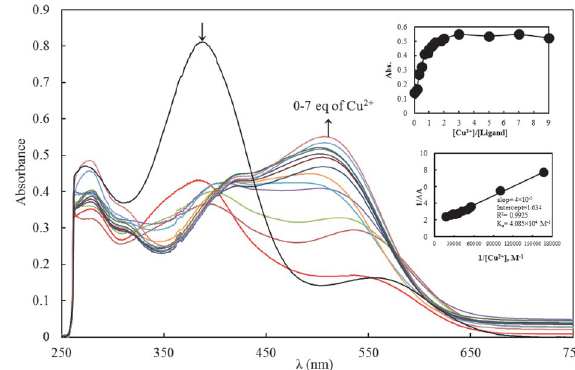
Fig. 5 . Changes in the UV–vis spectra of 1 (0.020 mM) upon titra- tion by Cu(CH 3 COO) 2 in a DMSO solution, where the concentra- tion of Cu(CH 3 COO) 2 varies from 0.004–0.14 mM. Insets: above: Absorption at selected wavelength versus equivalents of cation added, down; Benesi–Hildebrand plot of the receptor with Cu 2+